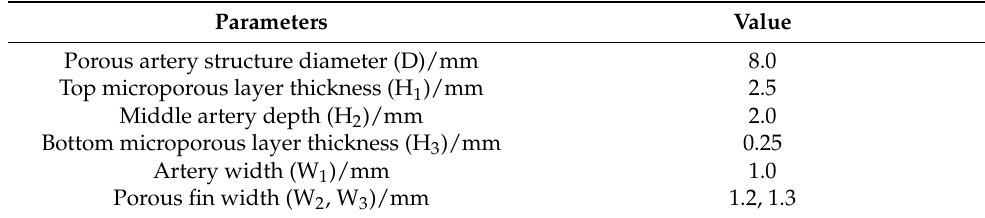
Figure 2. Schematic of the artery porous structure. In this porous structure, three rectangular arteries are located at the bottom of the copper porous structure, and there existed a thin, porous layer with uniform thickness of 0.25 mm between the arteries and the heating surface. The height of the artery is 2.0 mm, and the thickness of the top porous layer is 2.5 mm. The main parameters of porous artery structure are given in Table 1. Table 1. Main parameters of porous artery